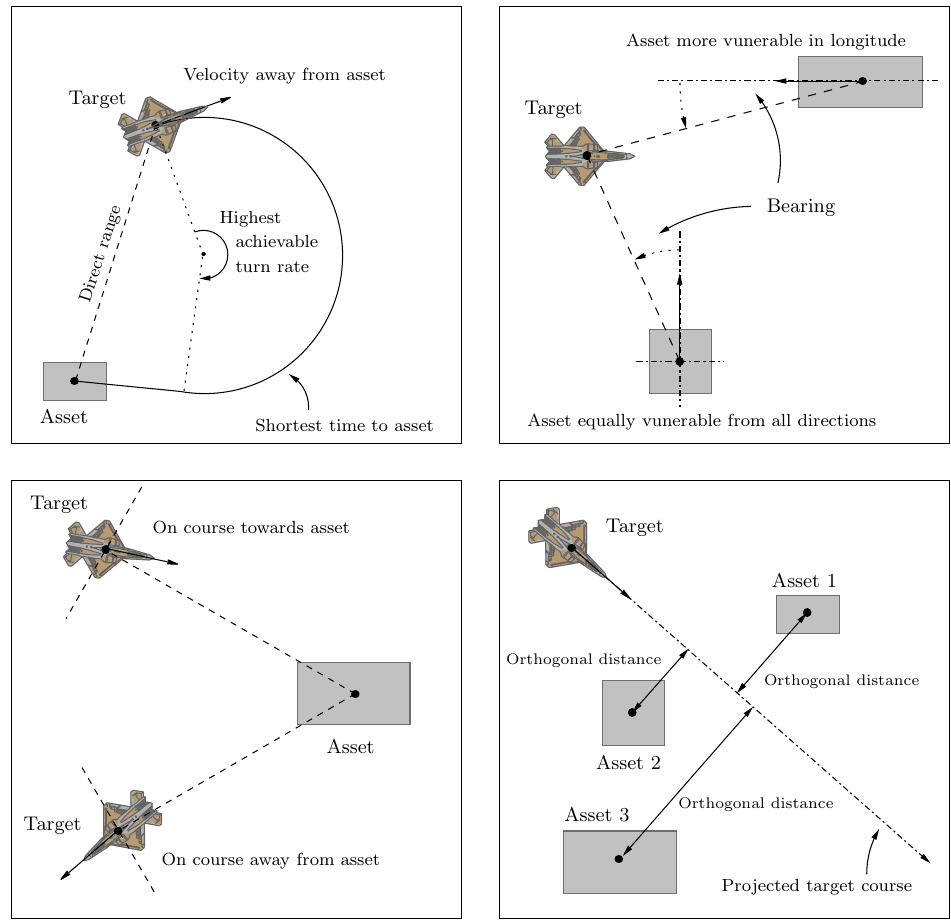
Figure 4: Deterministic TE